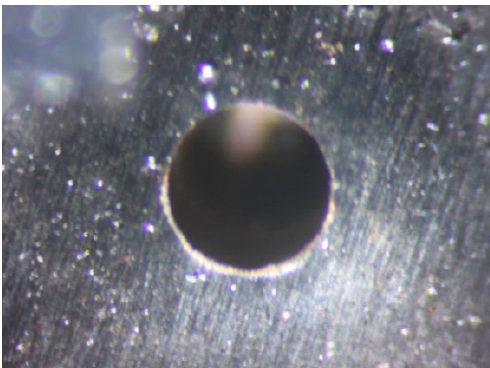
Figure 19. The titanium film residue with flyer sheared by the barrel.